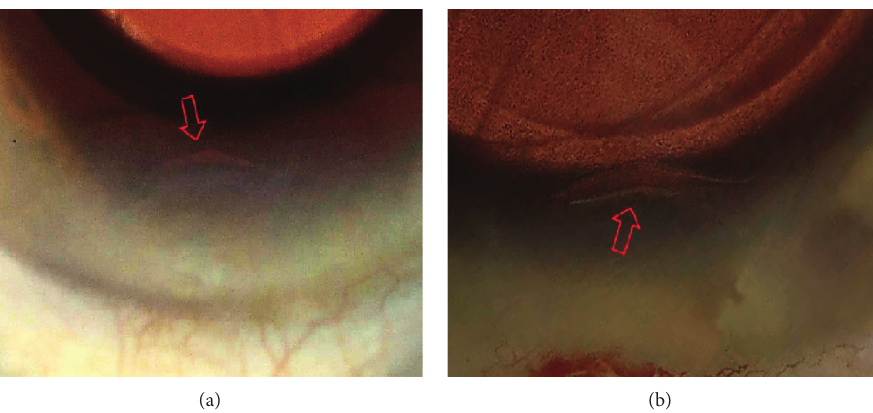
Figure 5: Photos of corneal incisions: the gap of the incision orifice (exposed central part of the incision ceiling) seen in photo from standard intraoperative video with different OCT findings (see Figure